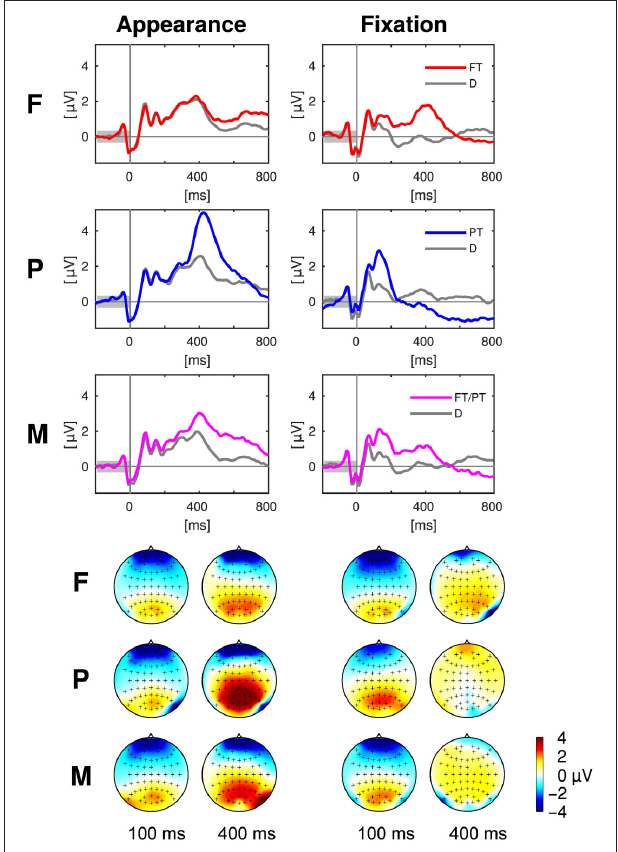
FIGURE 4 | Top: Event related potentials aligned to appearance and fixation of targets (colored) and distractors (gray) at the exemplary electrode Pz in the experimental conditions F, P, and M. Bottom: The scalp maps depict the head from above with the nose on top and show the potentials averaged over 50 ms long intervals centered at 100 and 400 ms after the target appearance (left) and fixation (right). Please note that the positivity (“yellow/orange/red”) at central, parietal and occipital electrodes was discriminative between targets and distractors in contrast to the negativity (“blue”) at prefrontal and anterior frontal electrodes (cf. Figure 5 ). Every figure throughout the paper summarizes the data of all 16 participants of the